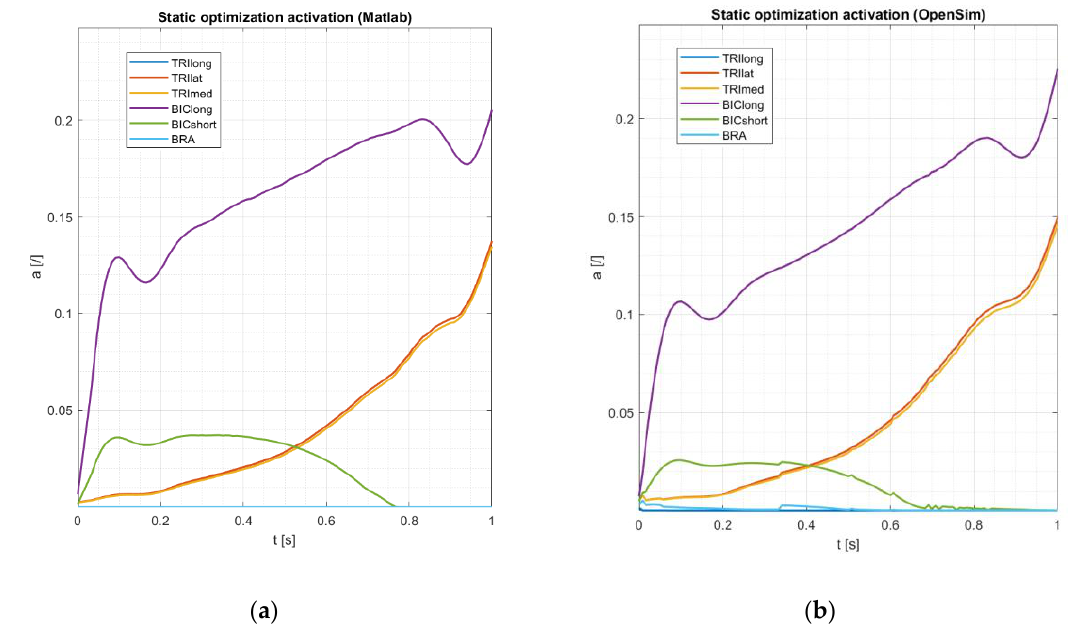
Figure 15. Muscles’ activations with physiological criterion and no passive forces: ( a) Matlab and ( b ) OpenSim).